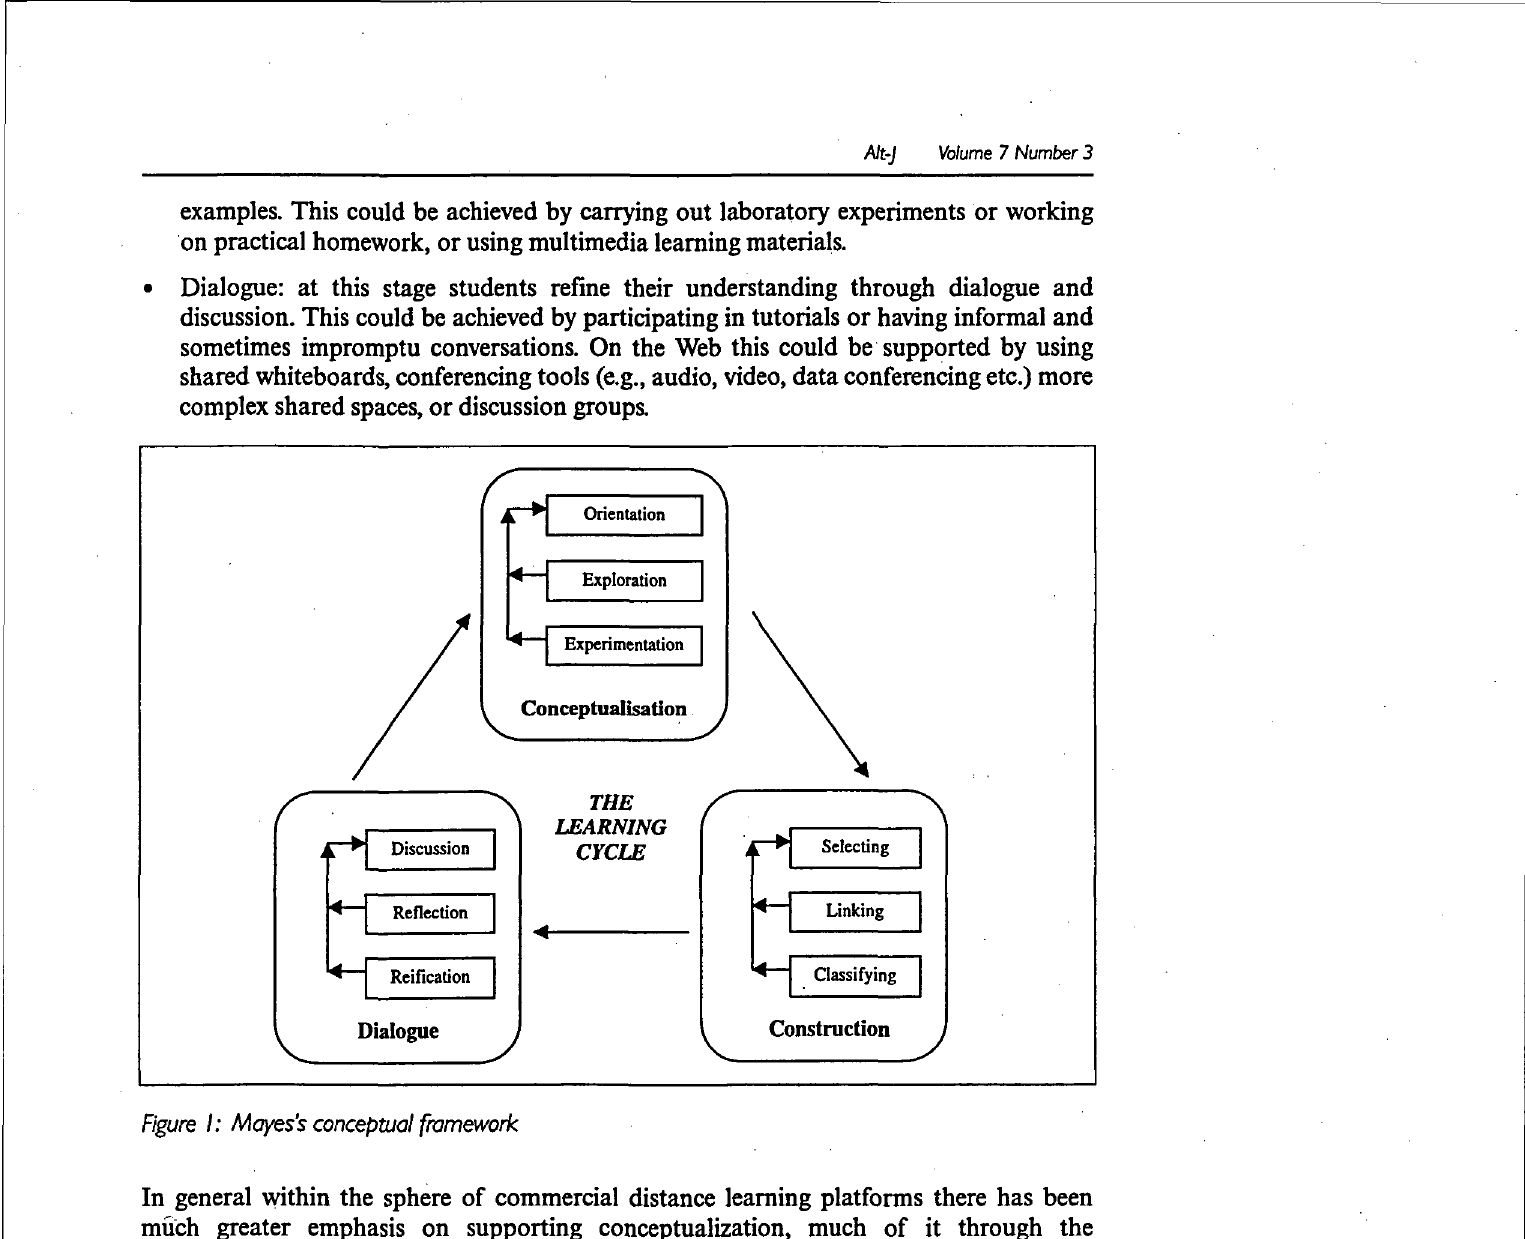
Figure I: Mayes's conceptual